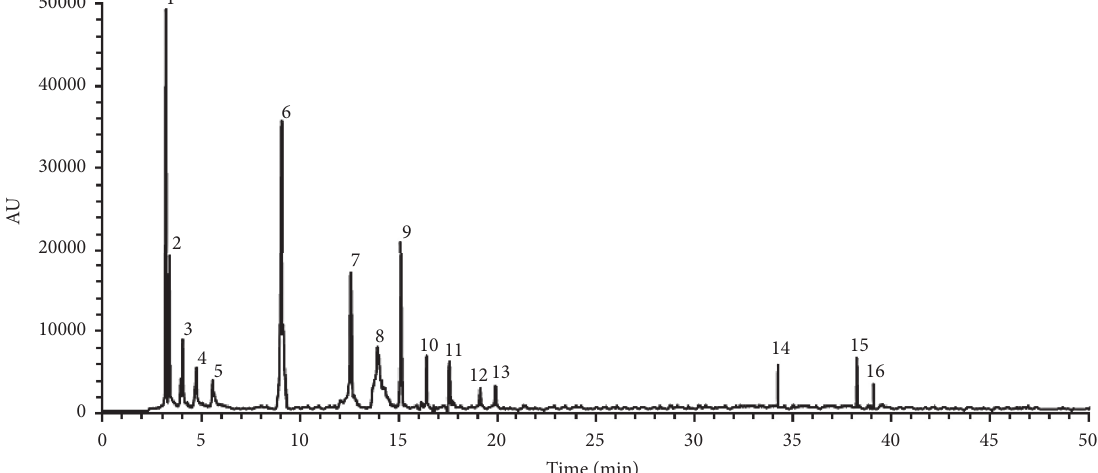
Figure 2: HPLC diagram of phenolic compounds of ethanolic extract.